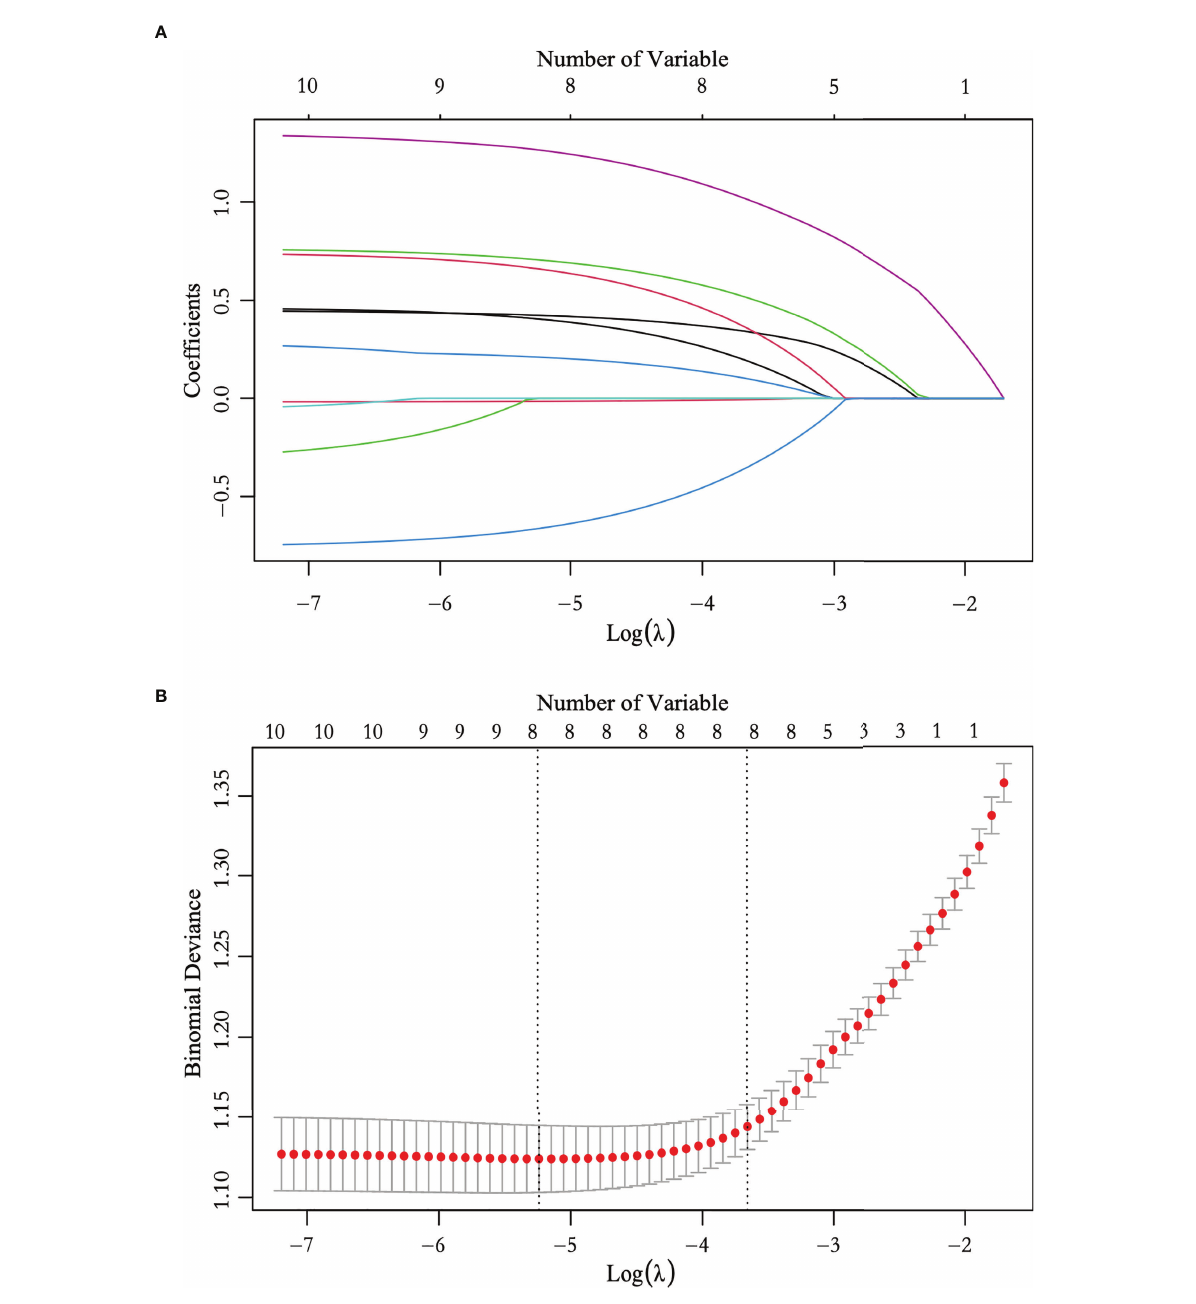
FIGURE 2 Feature selection using the least absolute shrinkage and selection operator (LASSO) logistic regression. (A) LASSO coef fi cient pro fi le plots of the 10 variables. (B) The selection of optimal predictive variables using cross-validation. Dotted vertical lines were drawn at the optimal values using the minimum criteria and the one-fold standard error of the minimum